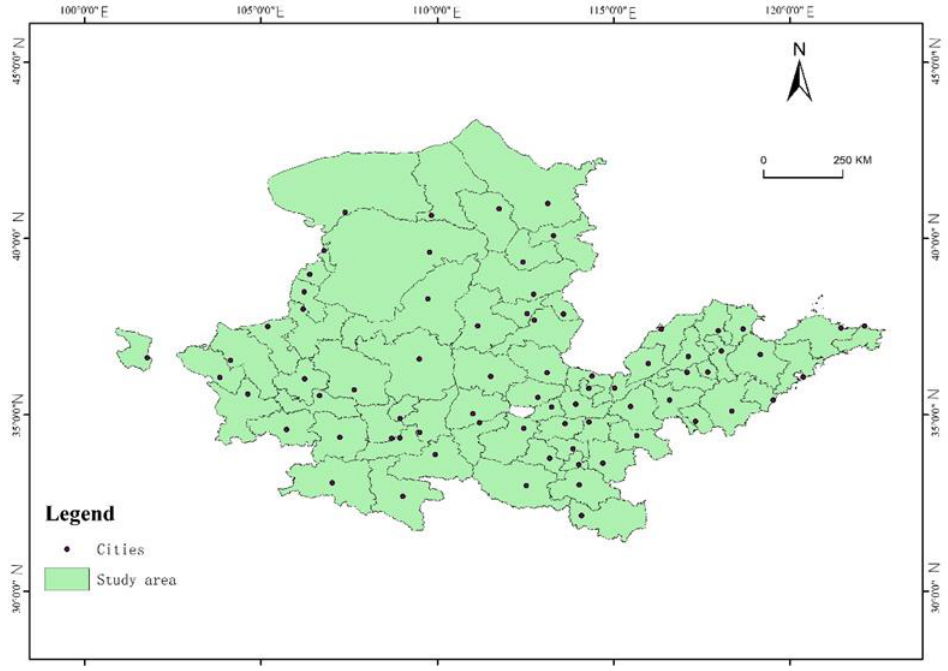
Figure 1. Sample area: the Yellow River Basin.